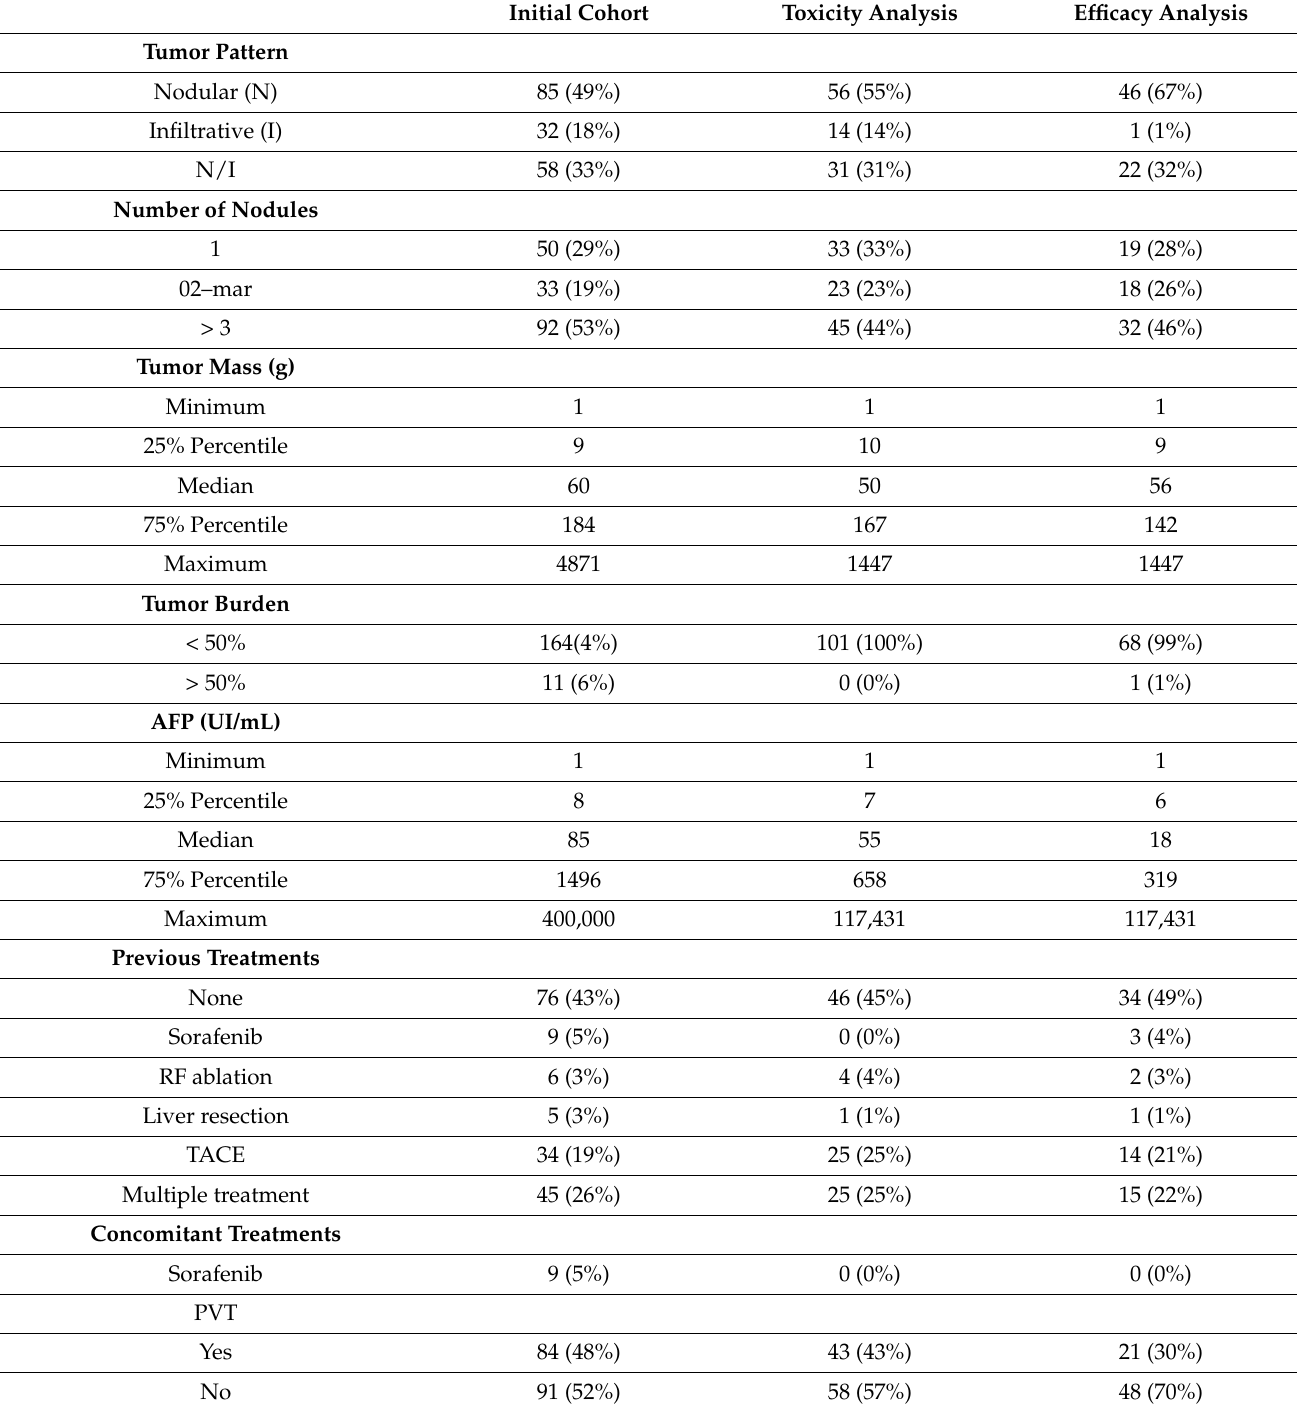
Table 1. Cont. Initial Cohort Toxicity Analysis Efficacy